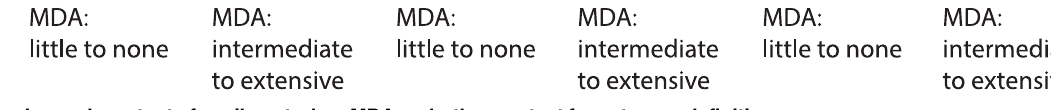
Fig 6. Prevalence change by extent of snail control, or MDA, or both — see text for category definitions.